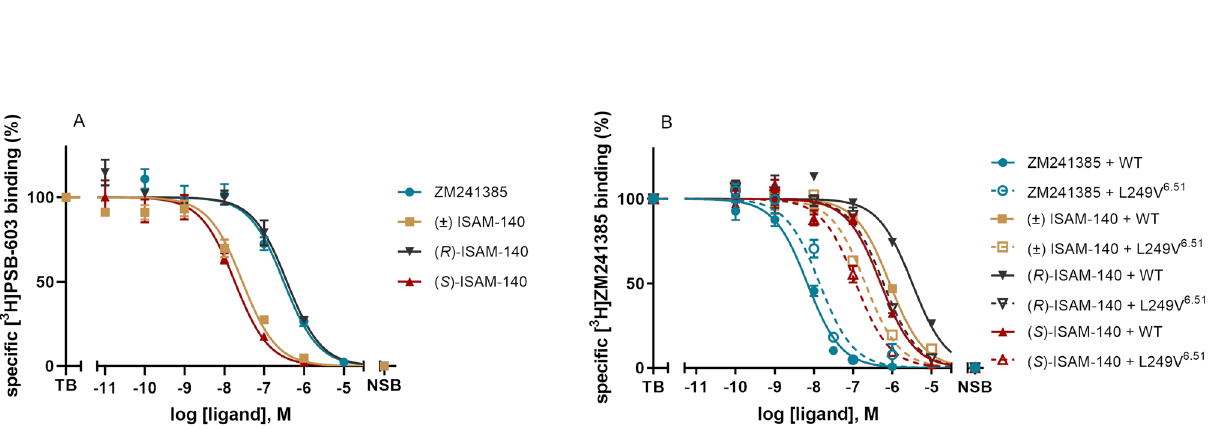
Figure 4. Displacement of (A) specific [ 3 H]PSB-603 binding from A 2B AR and (B) specific [ 3 H]ZM241385 binding from the WT and the L249V 6.51 mutant A 2A AR at 25 °C by ZM241385 (blue), ( ±) ISAM-140 (yellow), ( R )-ISAM-140 (black) and ( S )-ISAM-140 (red). Combined graphs are from three individual experiments performed in